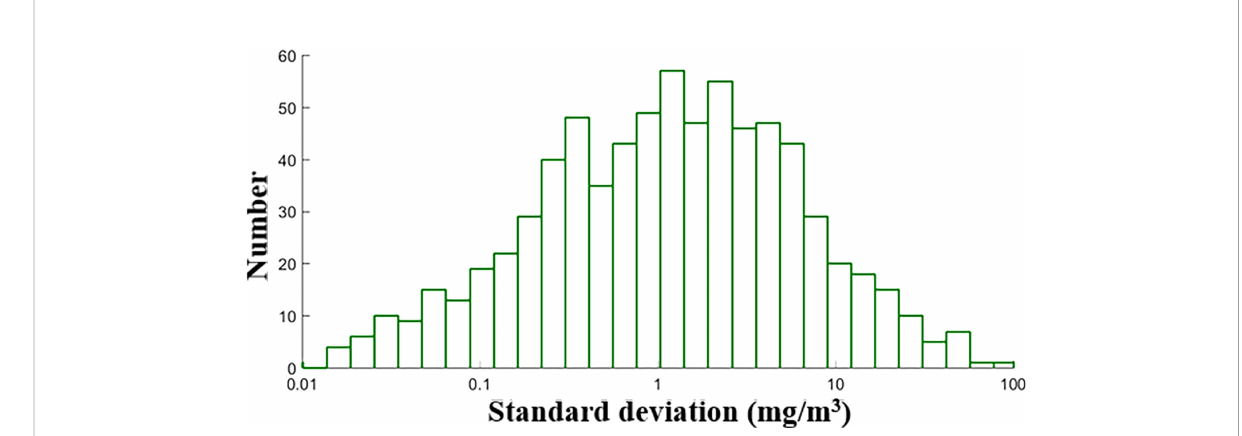
FIGURE 3 The histogram of standard deviation of in situ PON concentrations within the top 10 meters, and the scale of x-axis is in log10